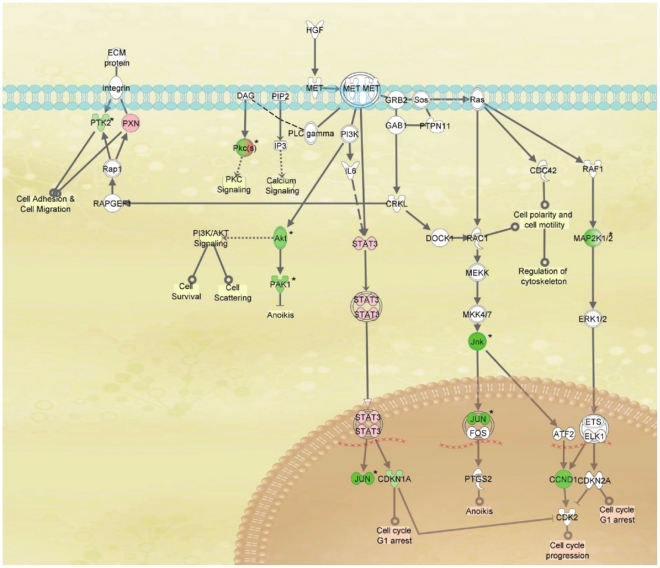
Top ranked HGF signaling pathway.Molecules in green are down-regulated in our microarray results while those in red are up-regulated. Proteins whose phosphorylation level was affected by TP421 treatment are denoted by *.